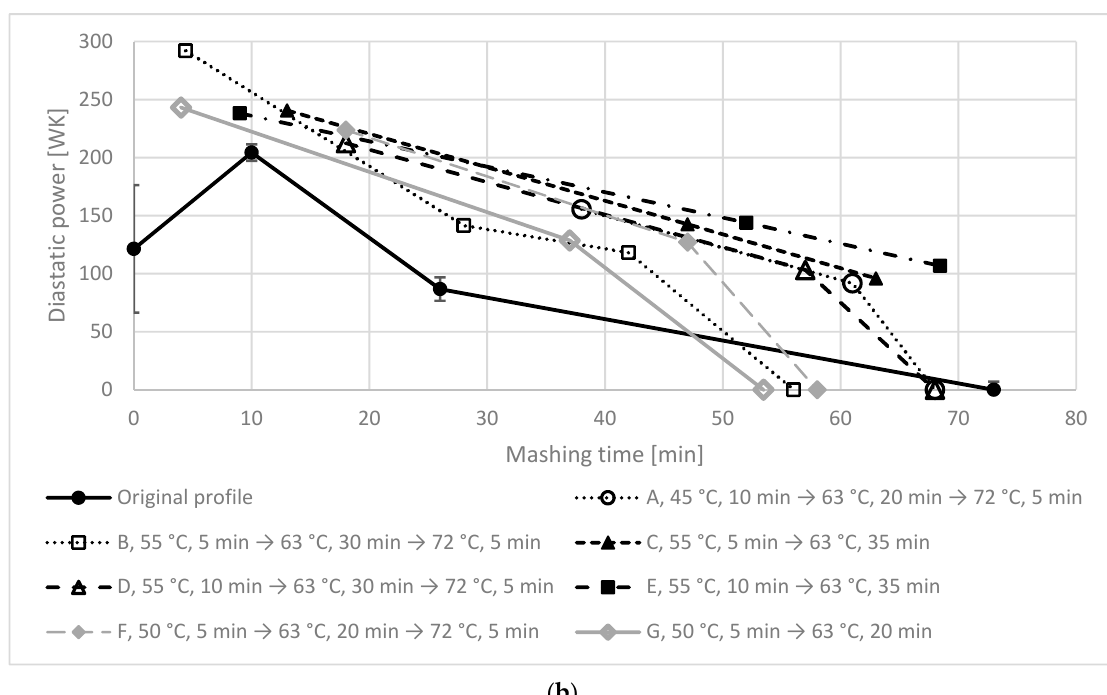
Figure 1. ( a ) α -Amylase and ( b ) β -Amylase activity of the different mashing profiles studied at lab scale measured with Brewer’s Dream™ kits. The heating rate in all profiles was 1 °C/min. Mash out temperature was 78 °C, which was held for 1 min.